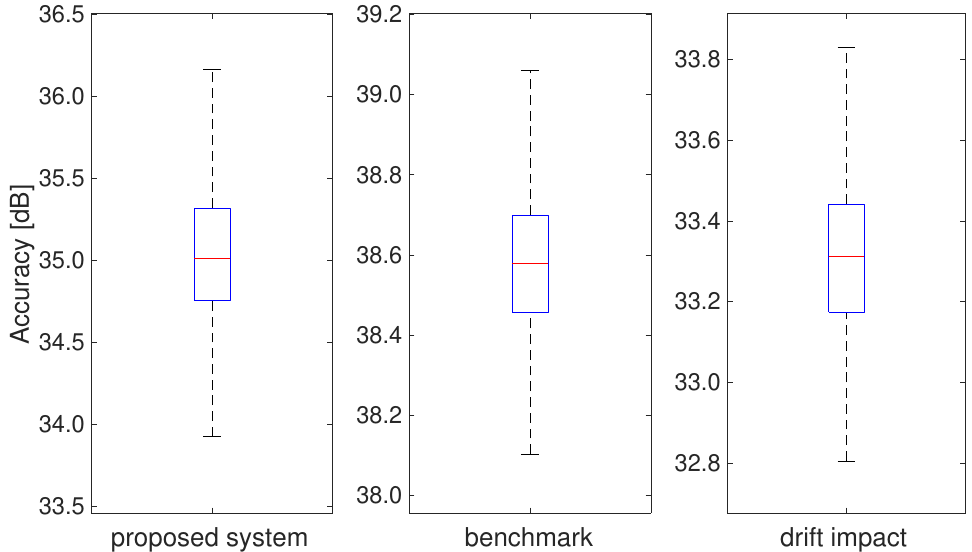
Figure 9. Accuracy offered by the proposed system (33.9–36.2) dB and the considered benchmark, both in ideal conditions (38.1–39.1) dB and in the presence of a constant offset equal to 1 ppm (relative to the output range of the accelerometer). The results are summarized by means of boxplots evaluated on 1000 tests performed on pseudo-random